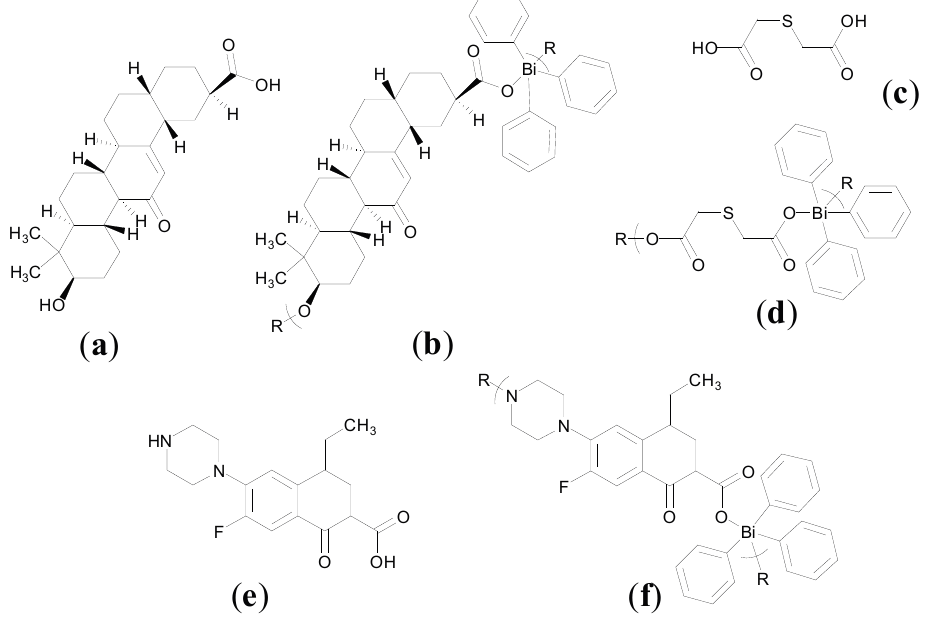
Figure 20. Structures of ( a ) GA, ( c ) TG and ( e ) NF and proposed structures for repeat units